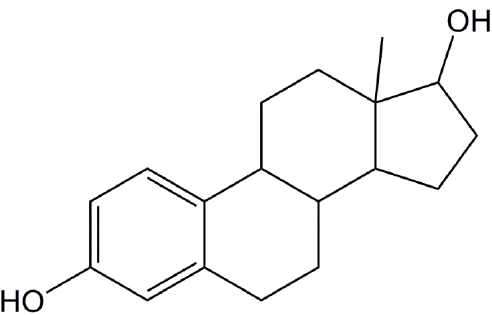
Figure 3. Structure of 17 β -estradiol.